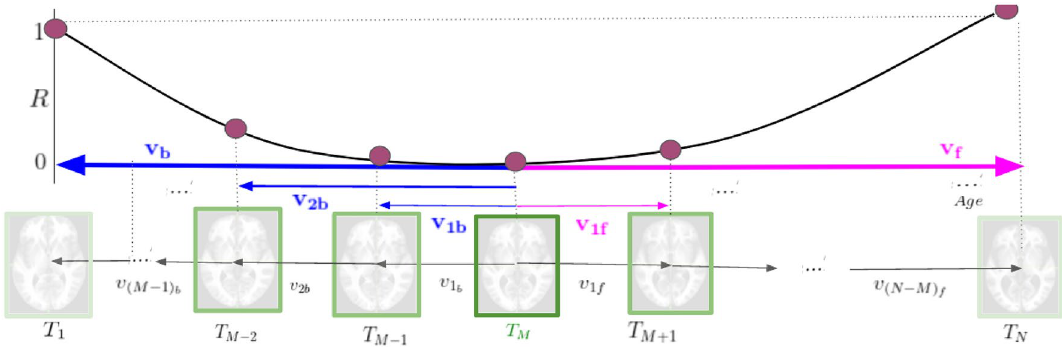
Figure 2. Illustration of the proposed aging deformation